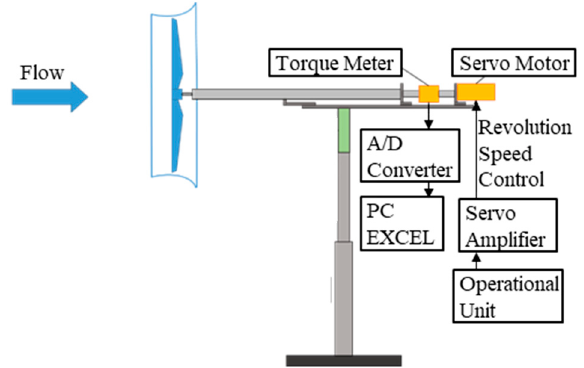
Figure 6. The various WLT brim shapes tested in the wind tunnel experiments: ( a ) Ci05 (circular brim, h = 0.05 D throat ); ( b ) Ci10 (circular brim, h = 0.10 D throat ); ( c ) Ci10_L6 (hexagon brim with straight sides, h = 0.10 D throat ); ( d ) Ci10_C6 (hexagon brim with curved sides, h = 0.10 D throat ); ( e ) Ci10_L12 (dodecagon brim with straight sides, h = 0.10 D throat ); ( f ) Ci10_C12 (dodecagon brim with curved sides, h = 0.10 D throat ).